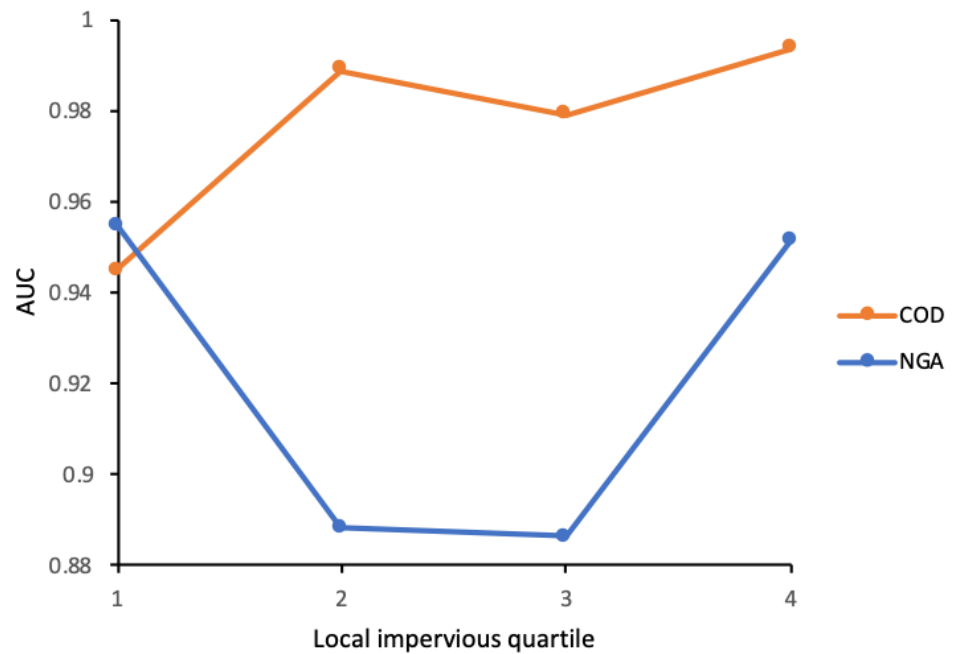
Figure 3. AUC values of the final building classification superlearner model by local impervious (urbanicity) quantile (a higher quantile value is more urban), for the Democratic Republic of the Congo and Nigeria.